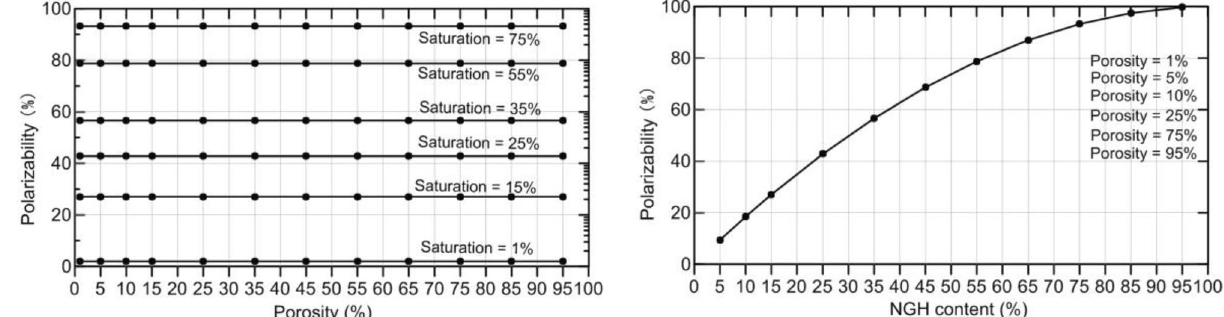
Figure 7. Polarizability as a function of porosity (left) and NGH saturation (right).